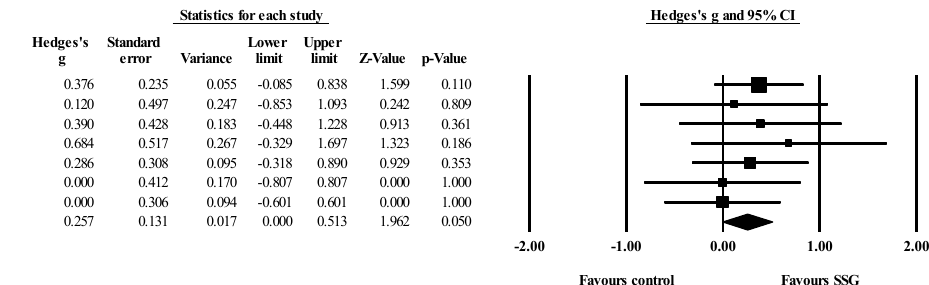
Figure 8) when compared to passive controls. For the assessment of publication bias, a